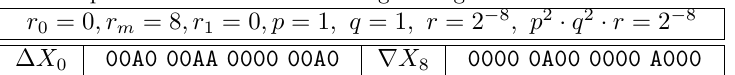
Table 5: Specification of the boomerang distinguisher for 8 rounds of